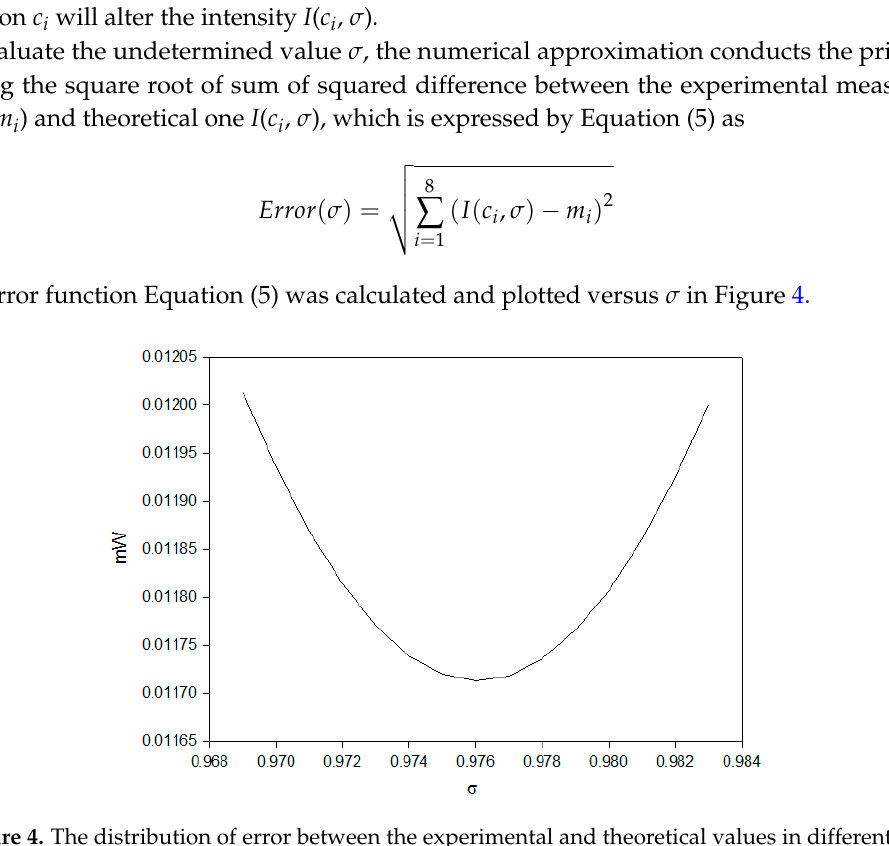
Figure 4. The distribution of error between the experimental and theoretical values in different σ .